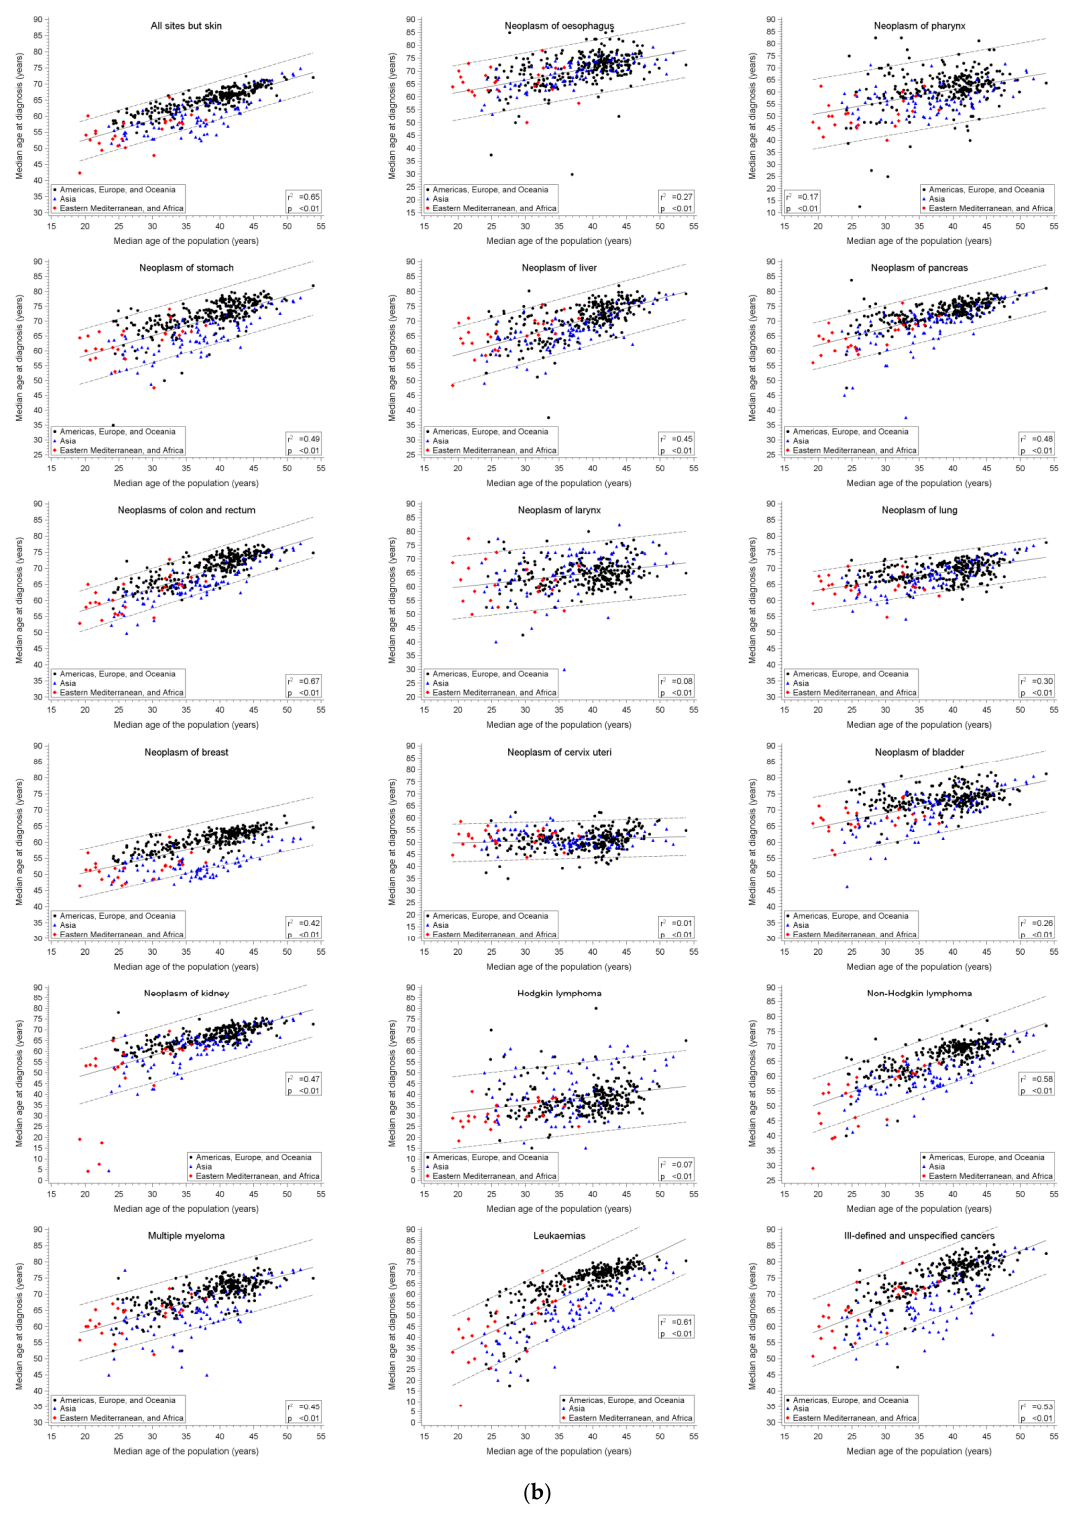
Figure 1. Scatter plots and linear regression with corresponding 95% predictive intervals, of the median age of the population (independent variable) vs. the median age of studied cancers cases in the populations recorded in all cancer registries listed in the XI volume of Cancer in Five Continents (period 2008–2012). ( a ) Males; ( b )